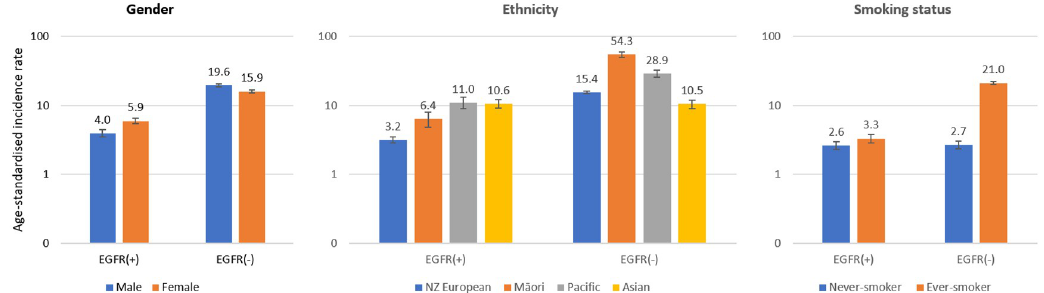
Fig 2. Age standardised incidence rates of non-squamous NSCLC (based on the EGFR mutation tested proportions) in terms of EGFR mutation status categorised by gender, ethnicity and smoking status. Age standardised rates represent cases per 100,000 person-years and are based on WHO world standard population. Analysis based on total 3815 non-squamous NSCLC; limited to 3776 in analyses by ethnicity; and limited to 1855 in analyses by smoking status due to missing data. Ever-smokers comprised current smokers and former smokers. The vertical error bars represent 95% confidence intervals of incidence rates.